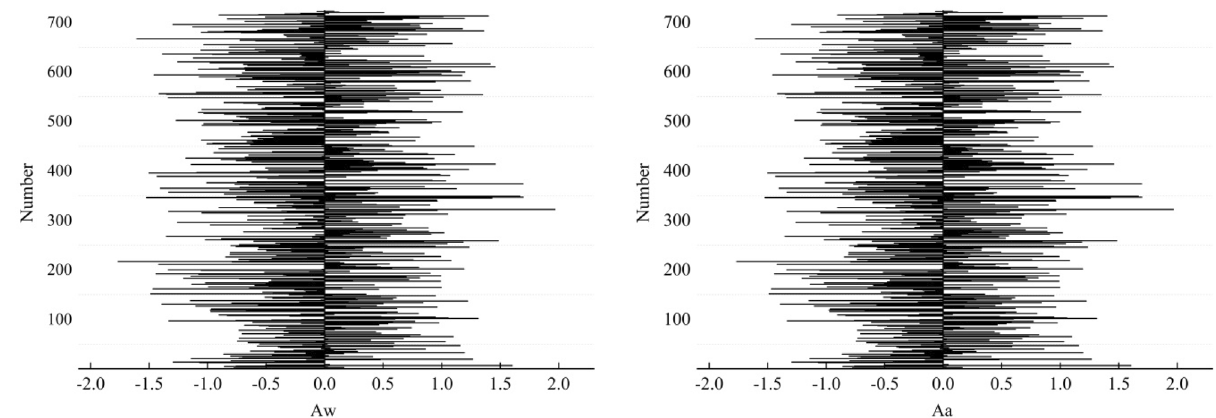
Figure 1. Statistical characteristics of the rill cross-sectional asymmetry